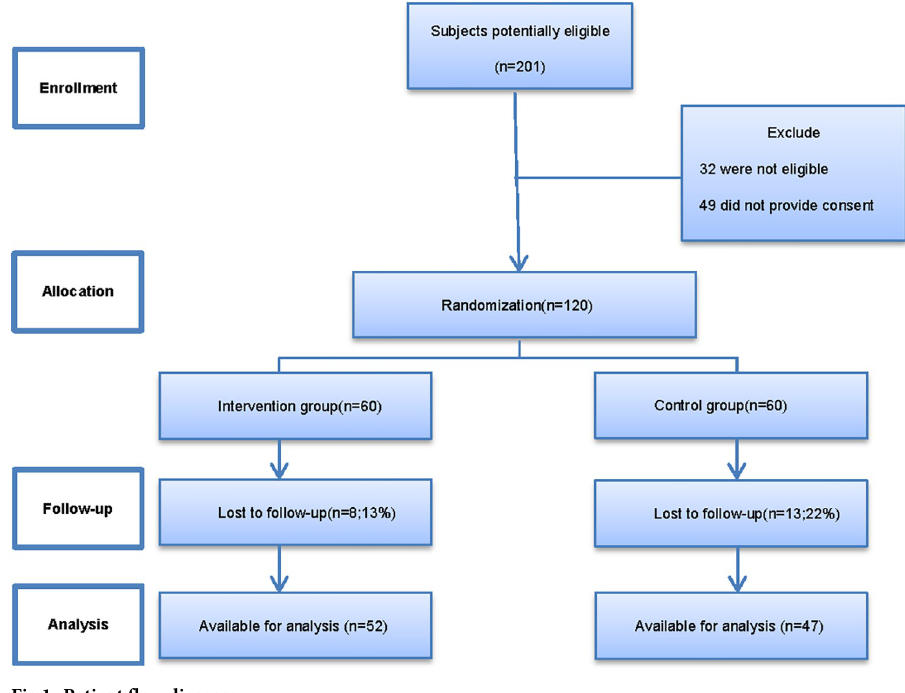
Fig 1. Patient flow